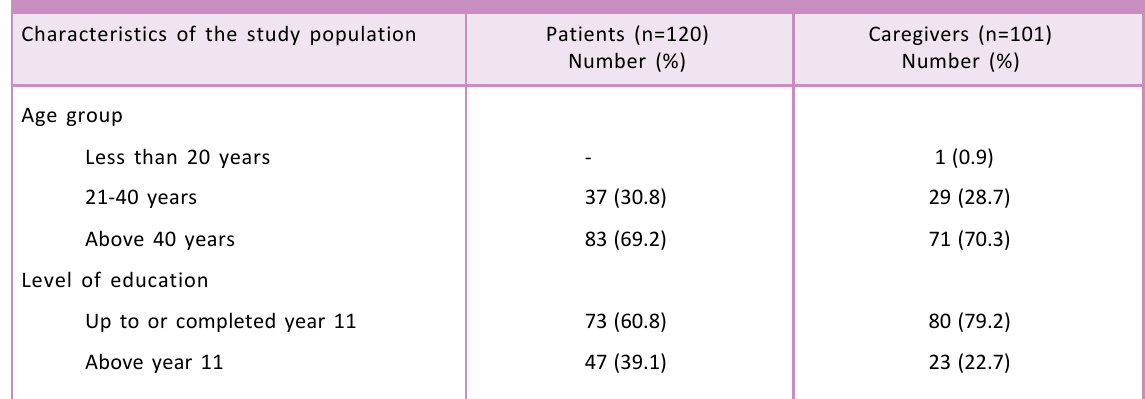
Table 1. Characteristics of the study